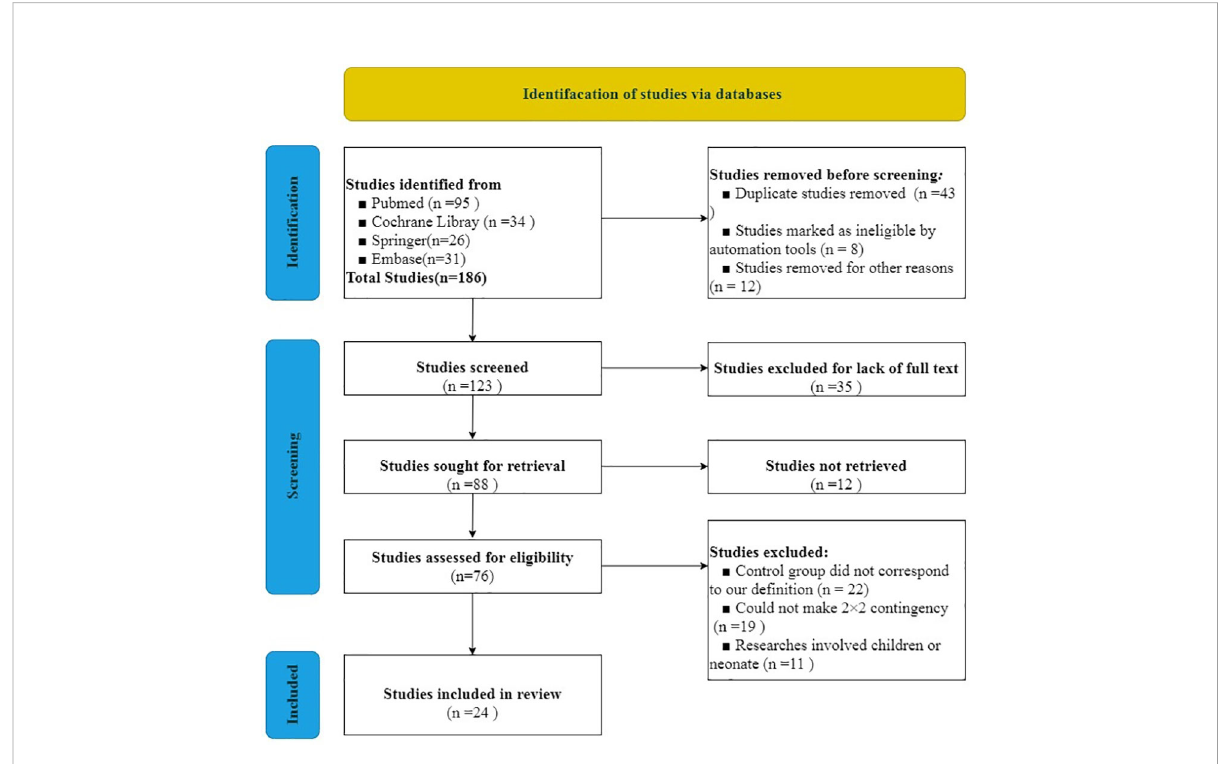
FIGURE 1 PRISMA Flowchart for selection of studies included in the systematic